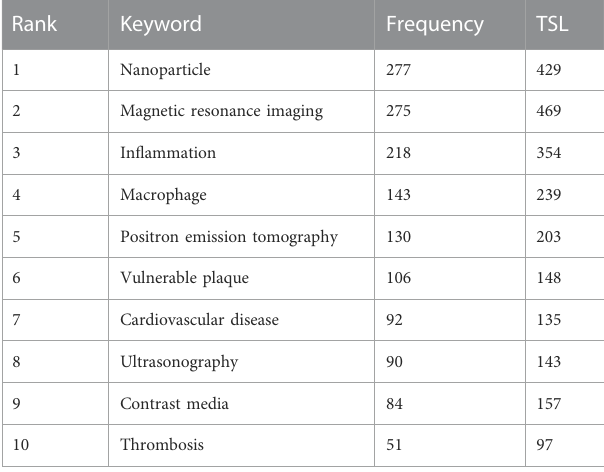
TABLE 5 Top 10 keywords of molecular imaging research in AS in terms of